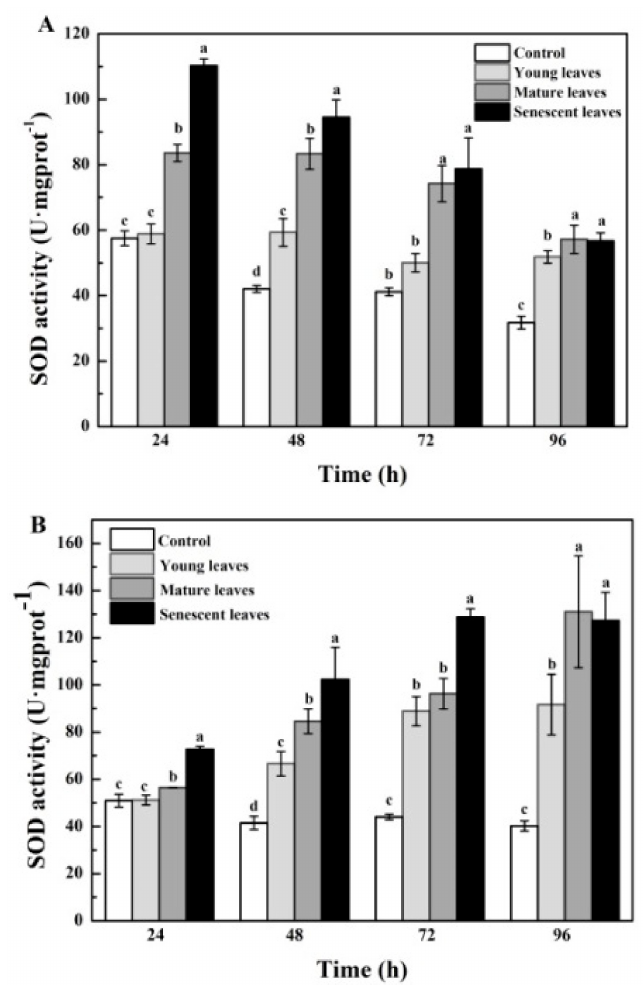
Figure 4. Superoxide dismutase (SOD) activity in P. globosa following treatment with mangrove leaf aqueous extracts of different leaf ages: ( A ) B. gymnorrhiza and ( B ) K. candel . The data are expressed as the mean ± standard error of the mean; n = 3 in each group. Values with different letters differ significantly from each other in the same time ( p <